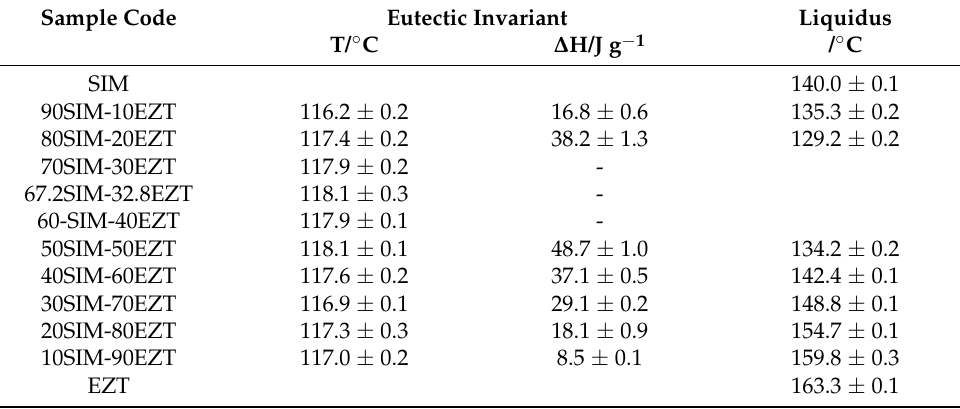
Table 2. Experimental temperatures and enthalpy values of phase transitions were observed in the SIM-EZT